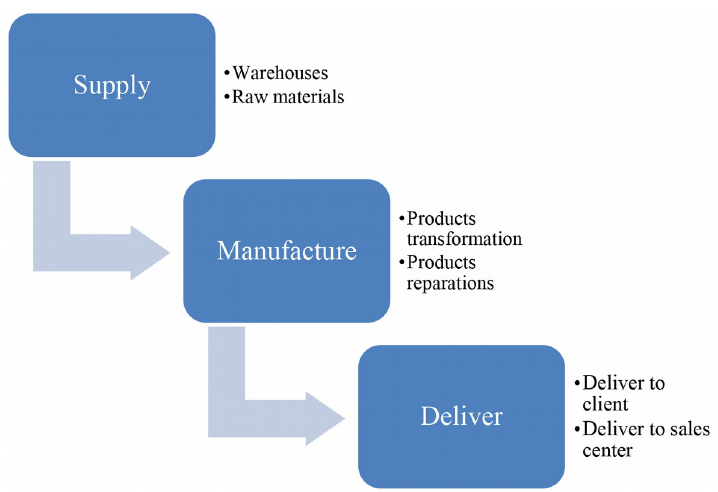
Figure 2. Direct chain model